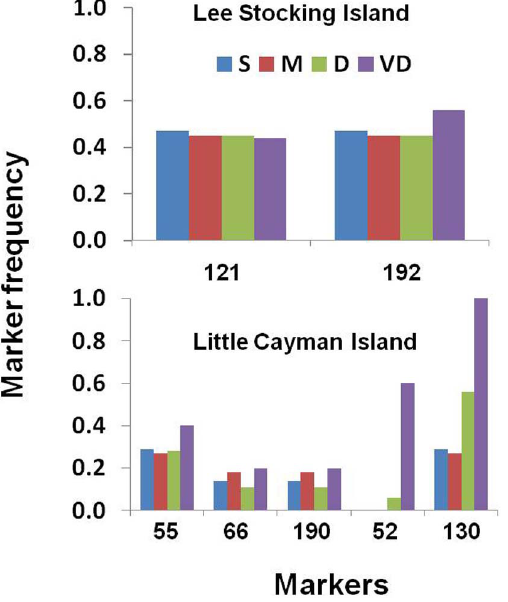
Figure 3. Plot of marker frequencies for three markers identified in the F ST outlier analysis to exhibit significant deviation from neutral expectations. The three markers in the Lee Stocking Island samples all showed significantly higher F ST compared to neutral expectations suggesting positive selection. The three markers in the Little Cayman Island data set all showed significantly lower F ST suggesting balancing selection.